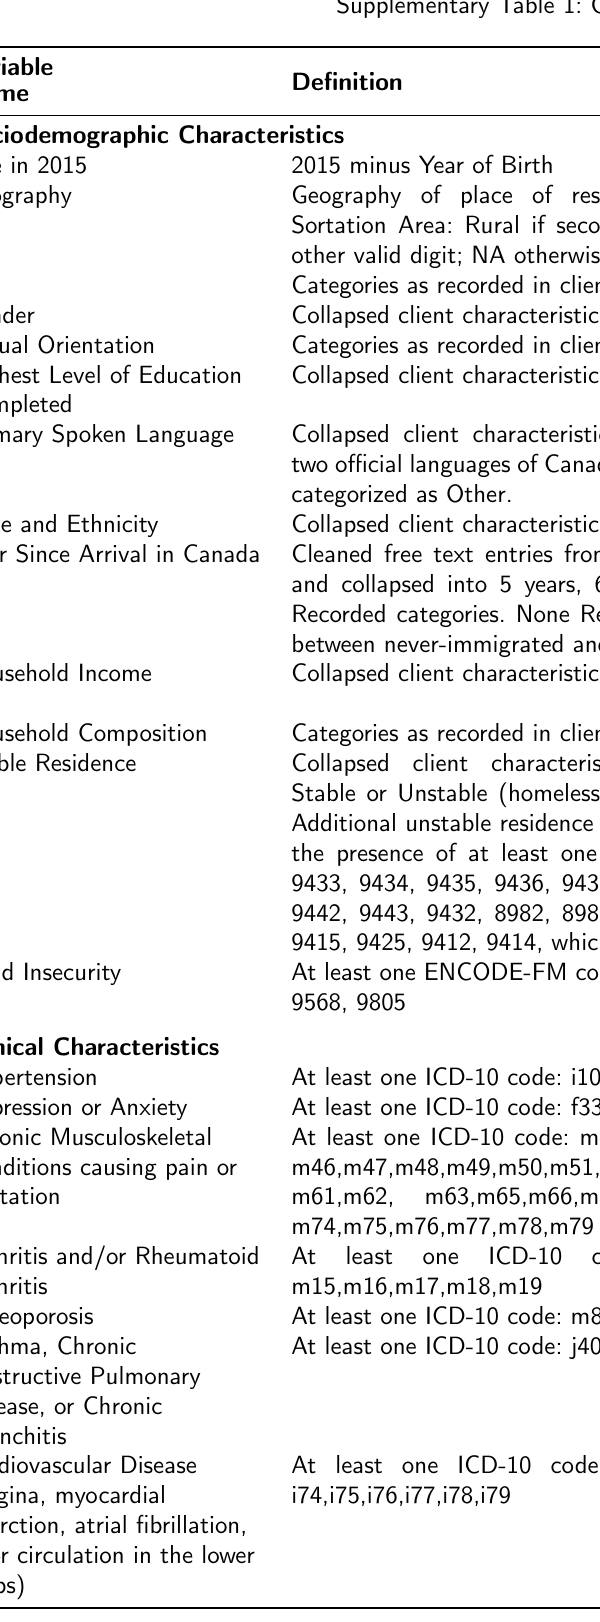
Supplementary Table 1: Characteristic variable